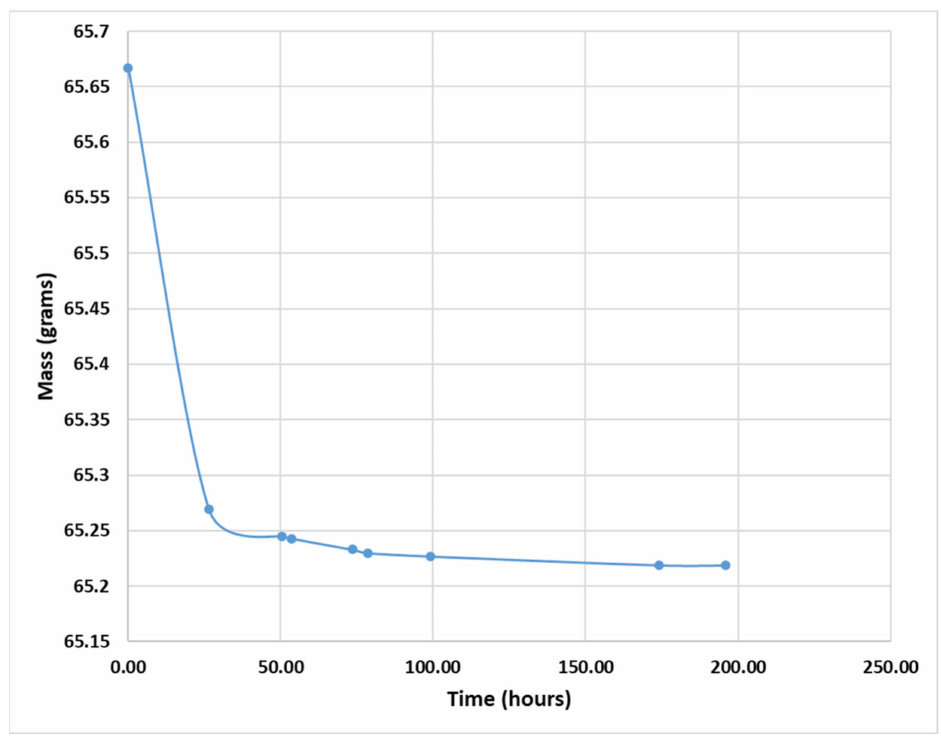
Figure 1. Sample weight versus time while drying the